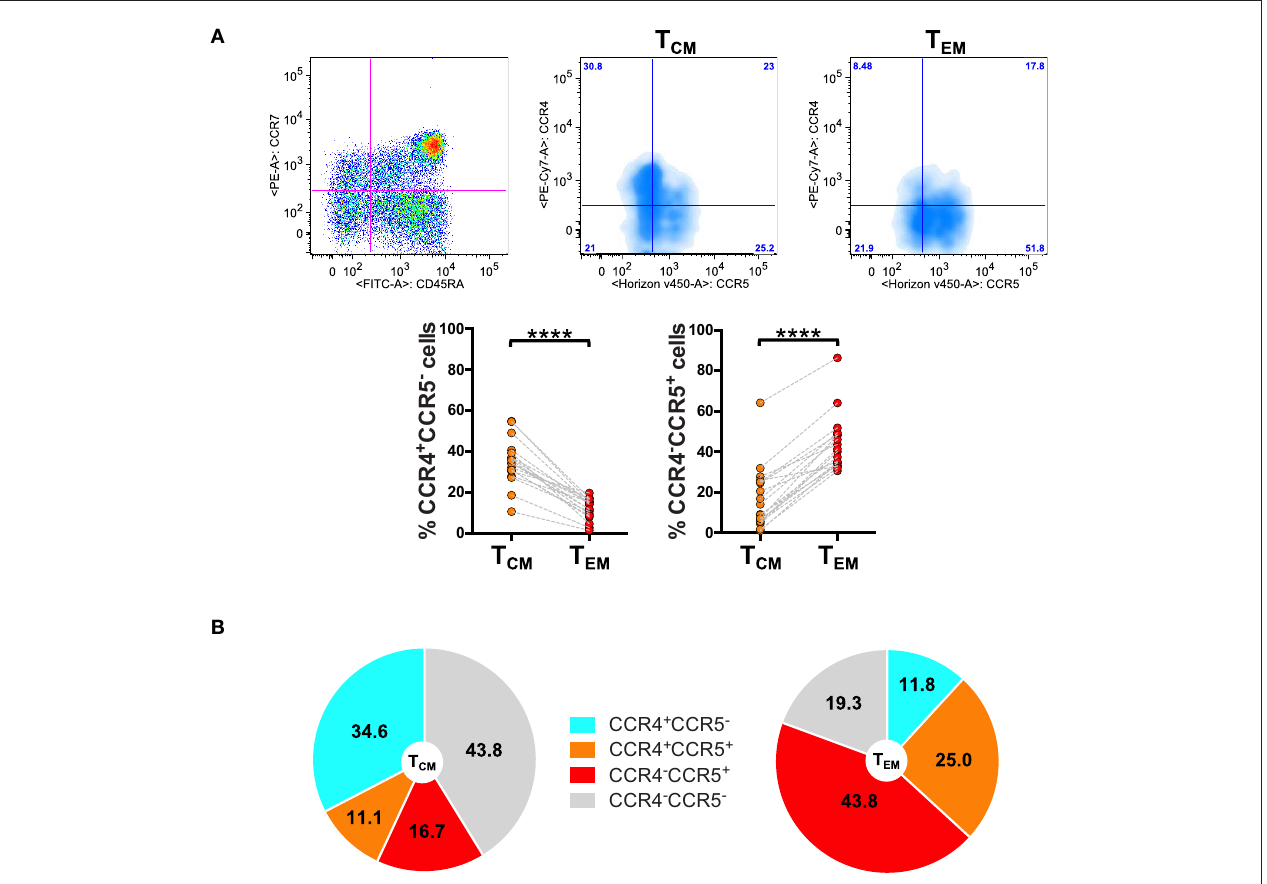
FIGURE 1 | Differential expression of CCR4 in CD8 + T CM and T EM cells. PBMCs isolated from healthy control subjects were stained for CD8, memory T cell phenotype markers (CD45RA and CCR7) and for chemokine receptors CCR4 and CCR5. (A) CD8 + T cells gated as CD45RA − CCR7 + T CM and CD45RA − CCR7 − T EM were analyzed for the expression of CCR4 and CCR5. Representative analysis is shown in the figure. The axis scales for fluorescence are reported as log. Statistical analysis of the differences was performed by Mann–Whitney test. p -values < 0.05 were considered significant: **** p < 0.0001. (B) Mean values of the percentage of CCR4/CCR5 subpopulations among T CM and T EM cells were shown in pie charts.